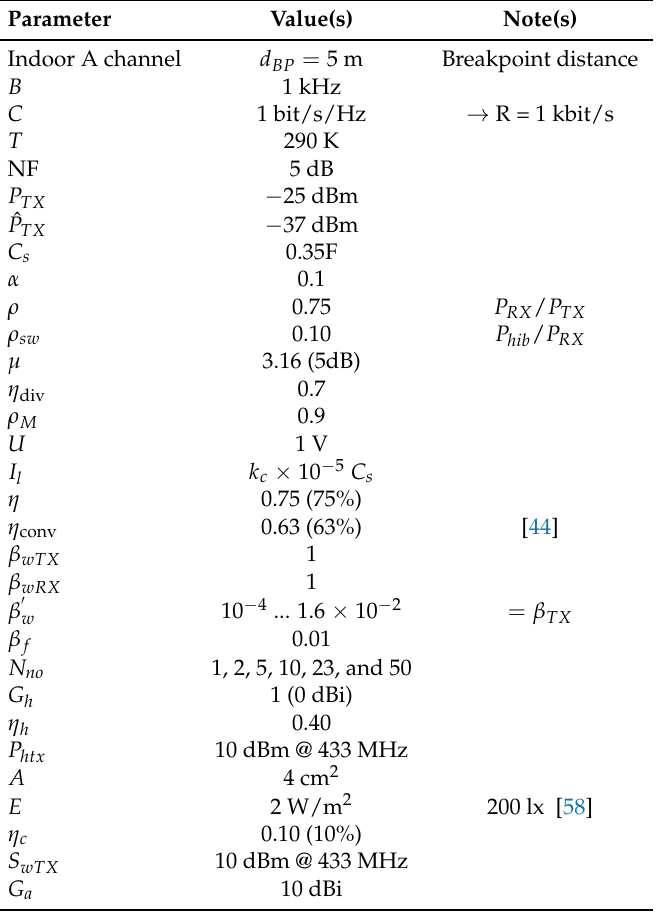
Table 4. Parameter values for